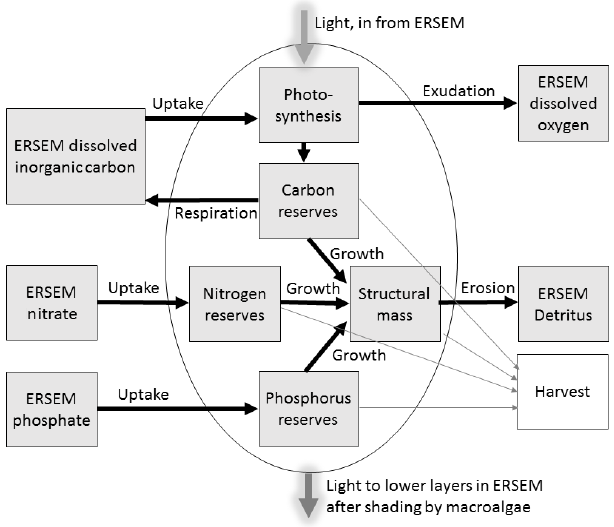
Figure 2. Schematic representation of the farmed macroal- gae in ERSEM-BFM, modified and expanded after Broch and Slagstad